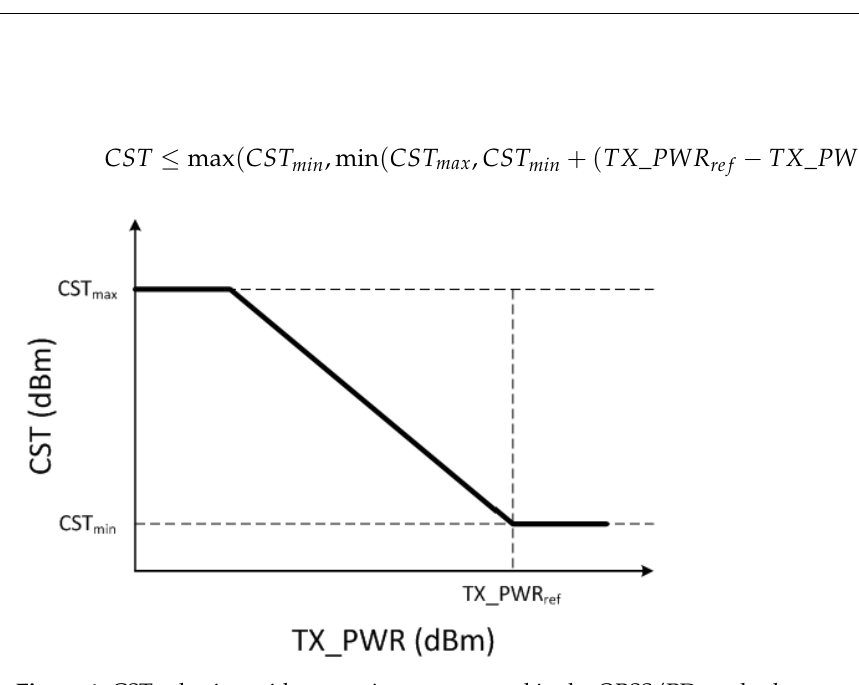
Figure 1. CST selection with transmit power control in the OBSS/PD